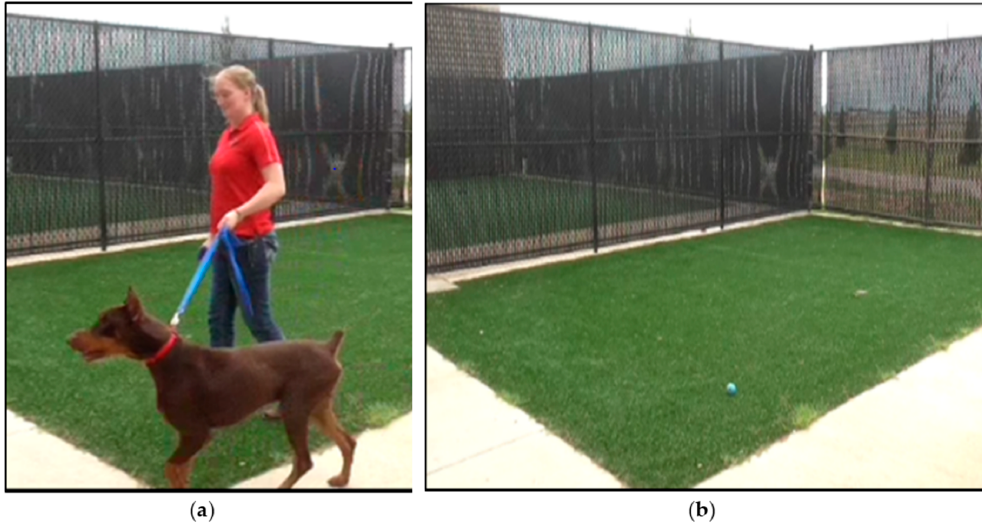
Figure 1. ( a ) Example of a dog being walked on a nylon leash and neck collar; ( b ) The yard in which dogs were